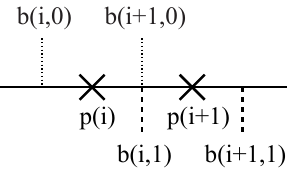
Figure 7. A one-dimensional coordinate variable with grid points p(i) and cell boundaries b(i,q) , i = 1 ,...,n ; q = 0 ,